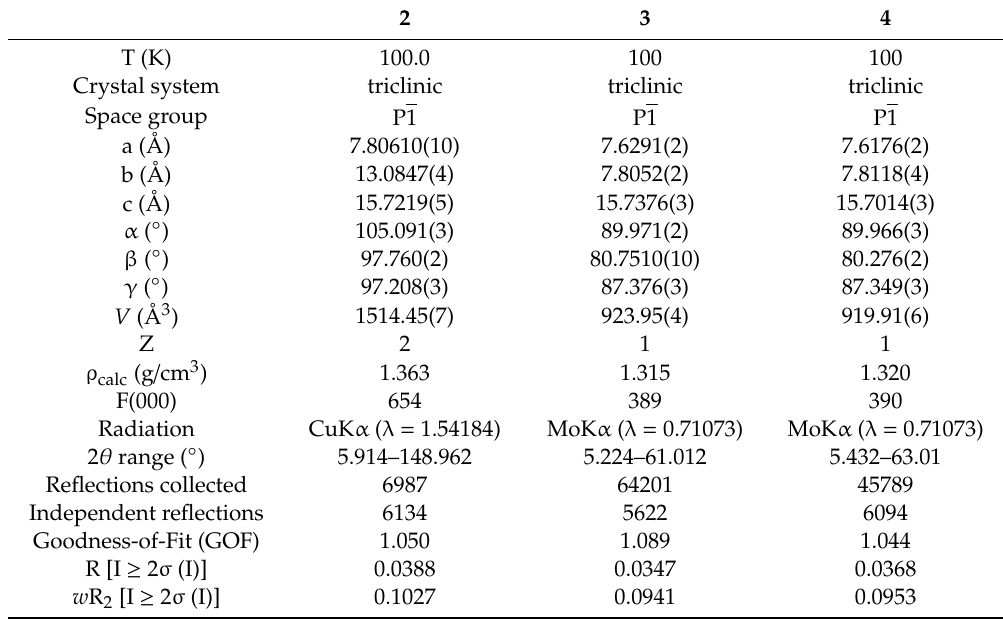
Table 2. Crystal data and structure refinement parameters for 2 – 4